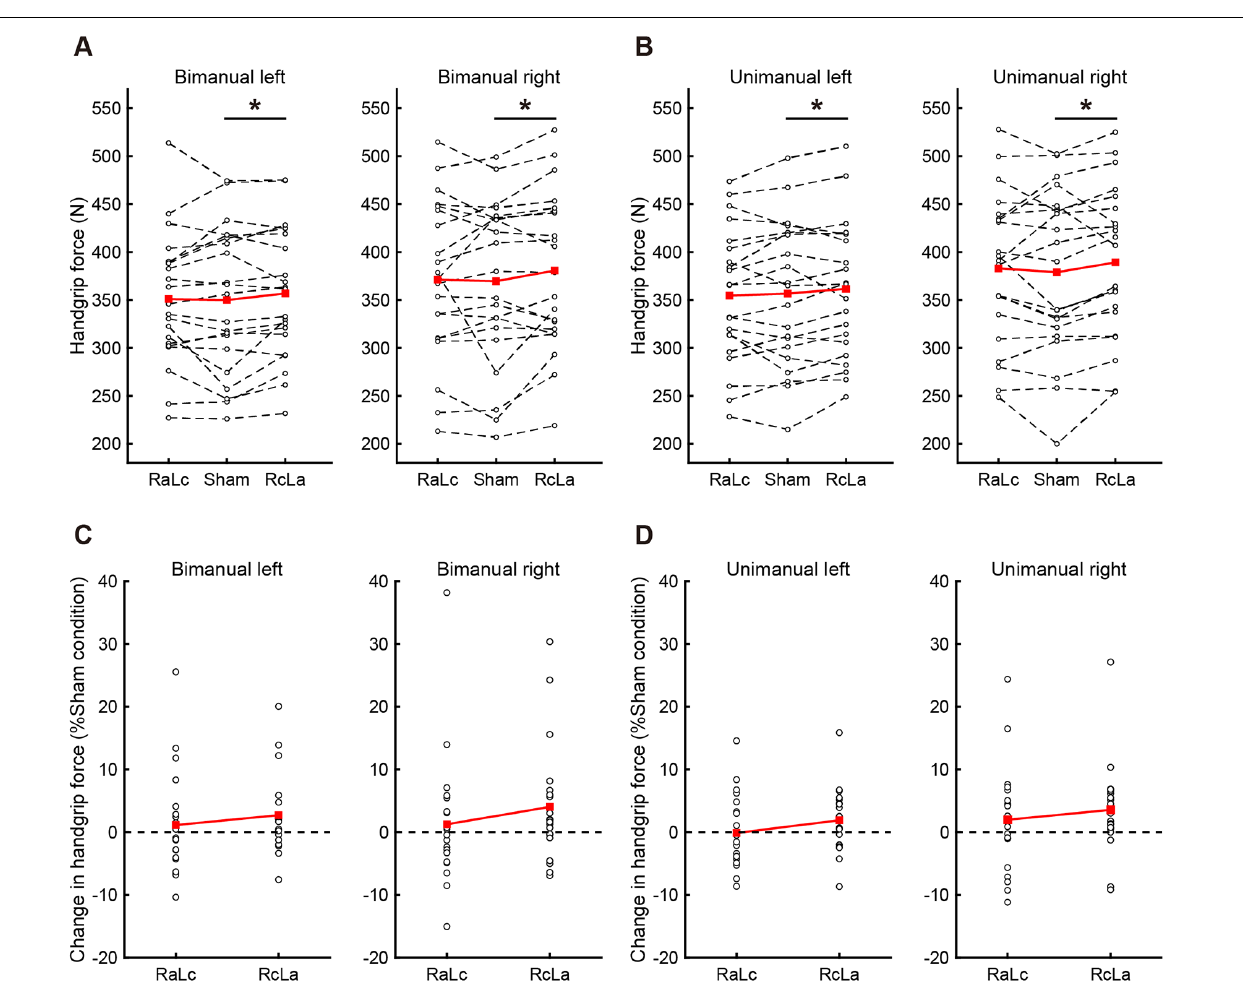
Frontiers in Human Neuroscience |